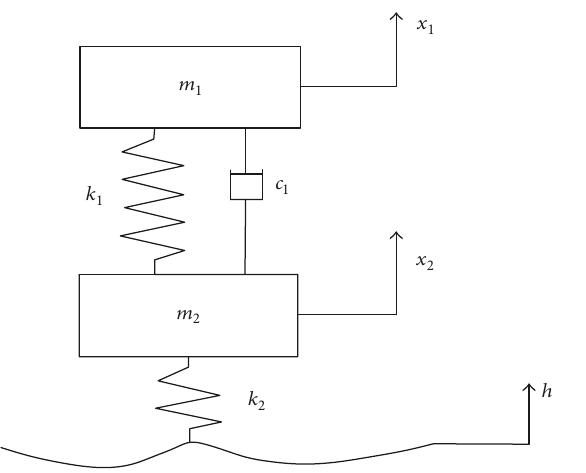
Figure 9: 1/4 physical model of the